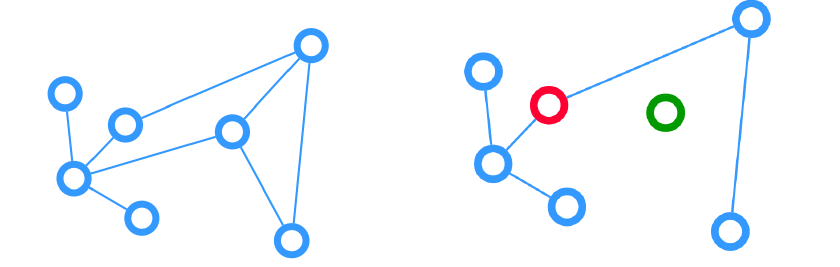
Figure 1. The left side shows a graph without protection or infection. On the right side, we see an infected node (red) and a protected node (green) in the same